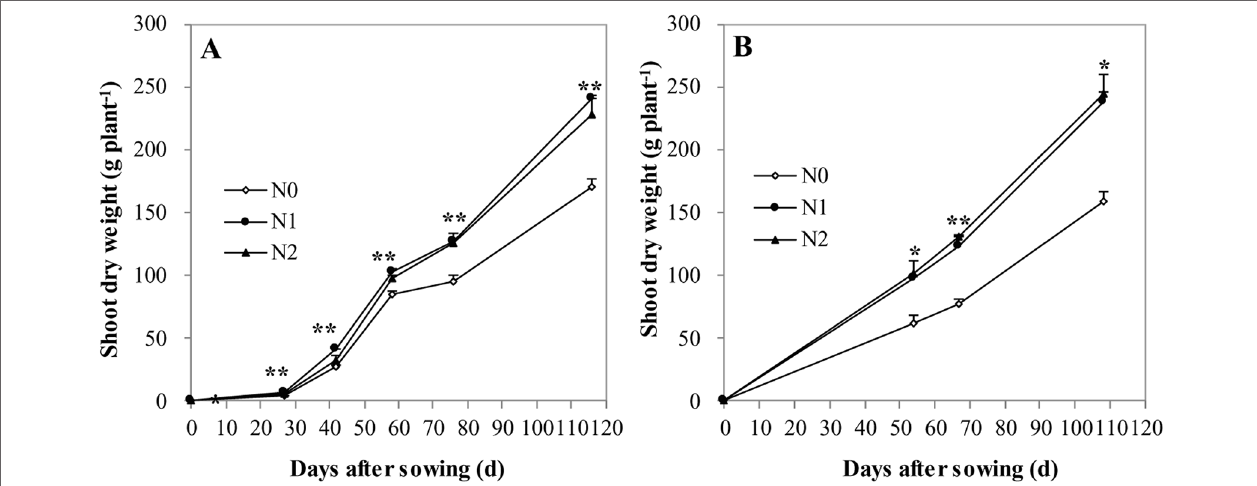
FIGURE 1 | The shoot biomass of summer maize at V6, V12, R1, R3, and R6 growth stages as affected by N application rates in the field in 2009 (A) and 2010 (B) , respectively. The error bars represent the standard error of the mean ( n = 4 in 2009 and n = 3 in 2010). *, ** indicate significant difference at P < 0.05, < 0.01, respectively.